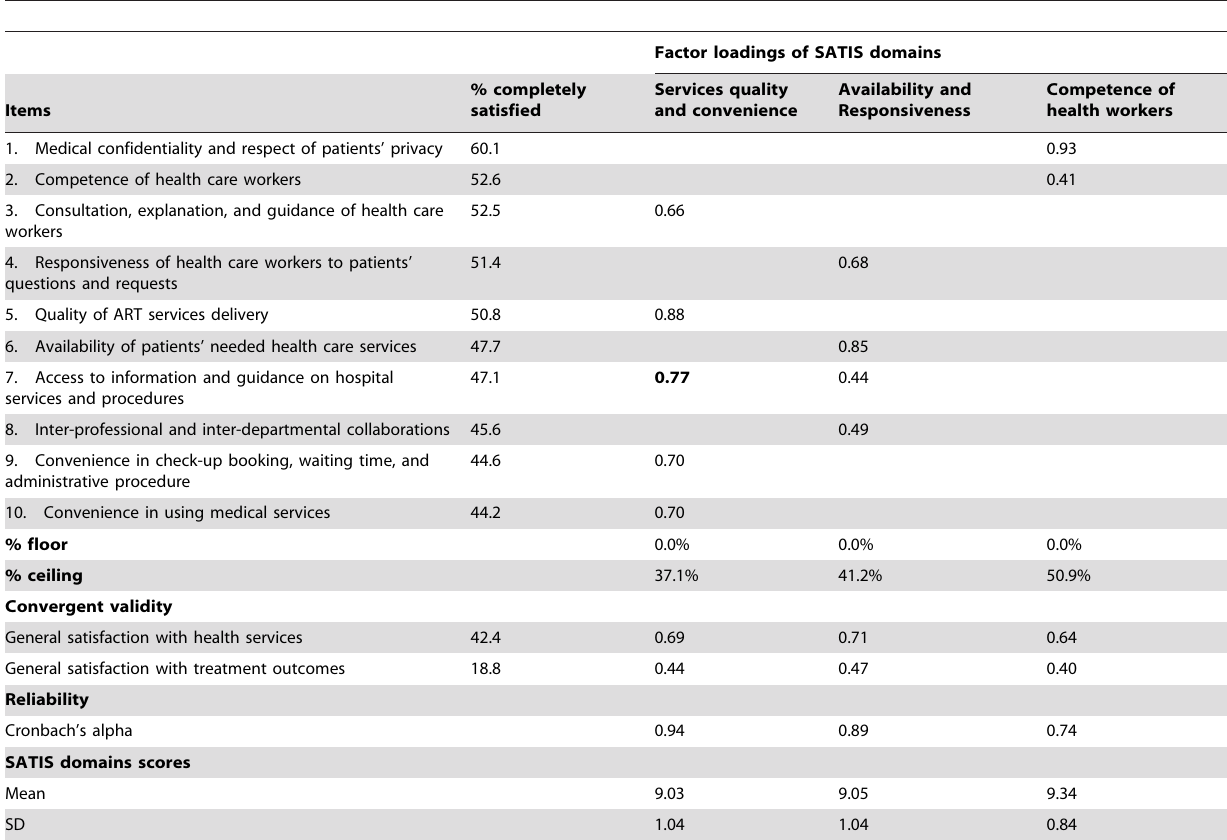
Table 2. Factor loading, convergent validity and reliability of the Vietnamese Satisfaction with HIV/AIDS Treatment Interview Scale